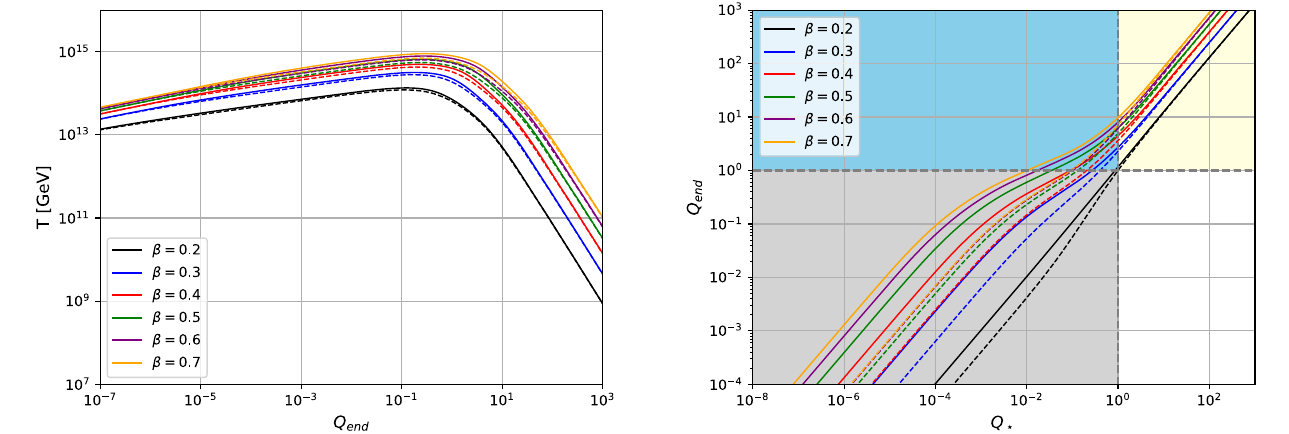
transition from weak to the strong regime during inflation (blue region). Solid lines correspond to λ = 0 . 05, while dashed lines correspond to λ = 0 .